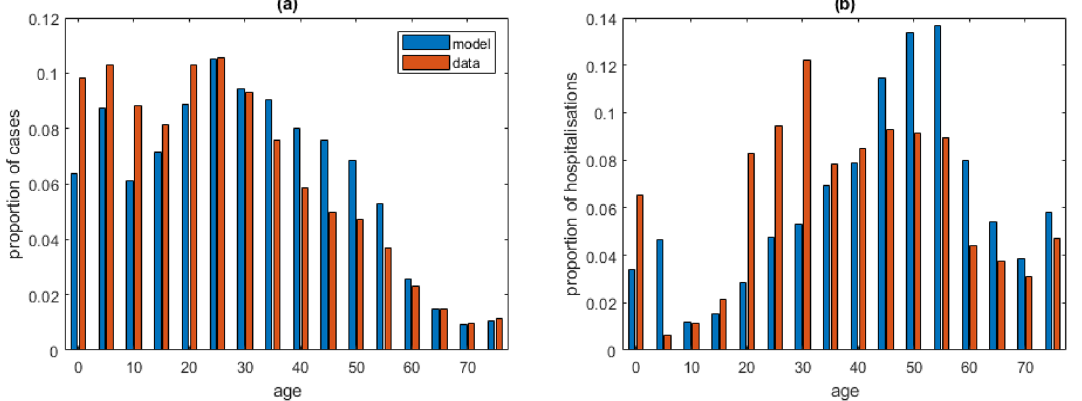
Figure 3. Age distribution of: ( a ) all cases; ( b ) hospitalised cases, comparing model (blue) with data (red) for New Zealand community cases reported between 17 August 2021 and 23 January the nowcasting package EpiNow2 23,45 appears more sensitive to slight variations in cases and shows a small cor- responding increase in R eff ( t ) after the shift to CPF red and a further increase after the shift to CPF orange. This highlights the potential impact of model (mis)specification or a poorly sampled parameter space on model-based projections and R eff ( t ) estimates. Despite these differences, however, the model reproduction number followed a reasonably similar trajectory to that estimated by EpiNow2 using daily cases up to 26 January 2022 45 and the 90% credible bands overlapped for the duration of the simulation. The model gave a reasonable match with the time series for hospital occupancy and deaths (Fig. 2d-f), which were not used in fitting the model. The age distribution of cases in the model was also qualitatively similar to the data (Fig. 3a), although the model underestimated the proportion of cases in the under 25 year age group and overestimated the proportion in the 35–60 year age group. The match to the age distribution of hospitalisations (Fig. 3b) was more variable, partly because the number of hospitalised cases was smaller. There have been more hospitalisations of under-5-year-olds than the model estimates (although a significant proportion of these may have been social admissions or for non-COVID-19 related treatment). The bulk of hospitalised cases were in the 20–60 year age group in both model and data. We retrospectively investigated the results of fitting the model to data on cases in the first part of the outbreak and comparing with the future epidemic trajectory. These model results are not predictions because they do not take account of likely future changes in restrictions and/or behaviour. Rather, they are projections of the epidemic dynamics under the assumption that contact rates, as quantified by the control function C ( t ) , remain constant subsequent to the fitted time period. After fitting to case data up to 28 November 2021, approximately coinciding with the peak in reported cases, the fit of the model to in-sample data was good, but the model projection tended